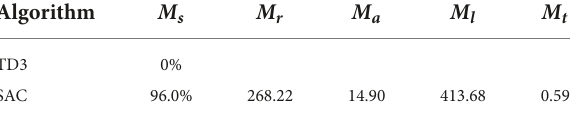
TABLE 3 Comparison of metrics in testing environment